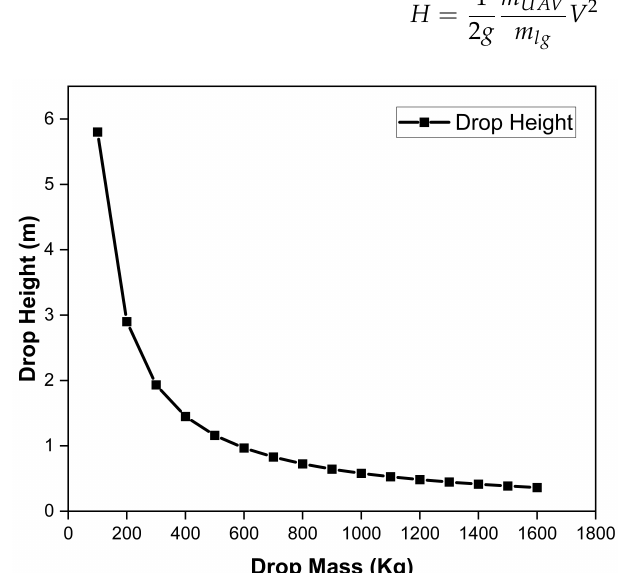
Figure 11. Variation of drop height with dropping mass for product-based qualification of landing gear